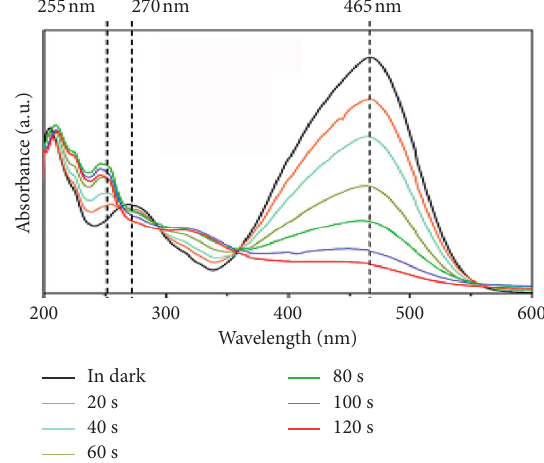
Figure 10: UV-Vis spectrum of MO solution in photodegradation process